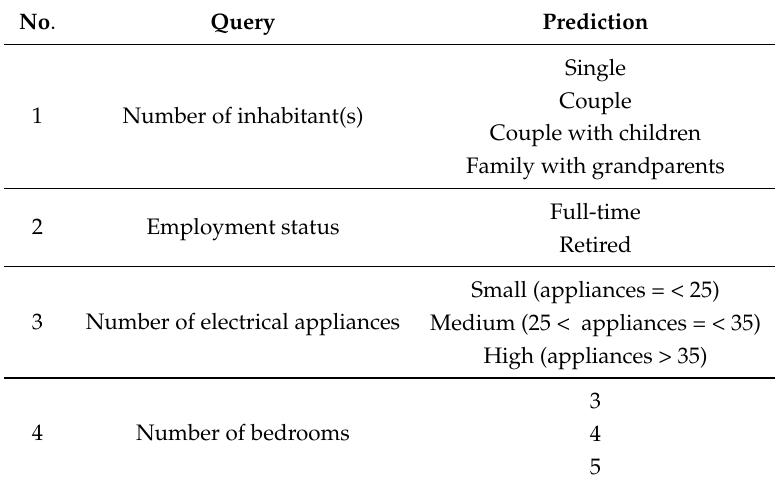
Table 3. Analyst query to infer the household characteristics of residential